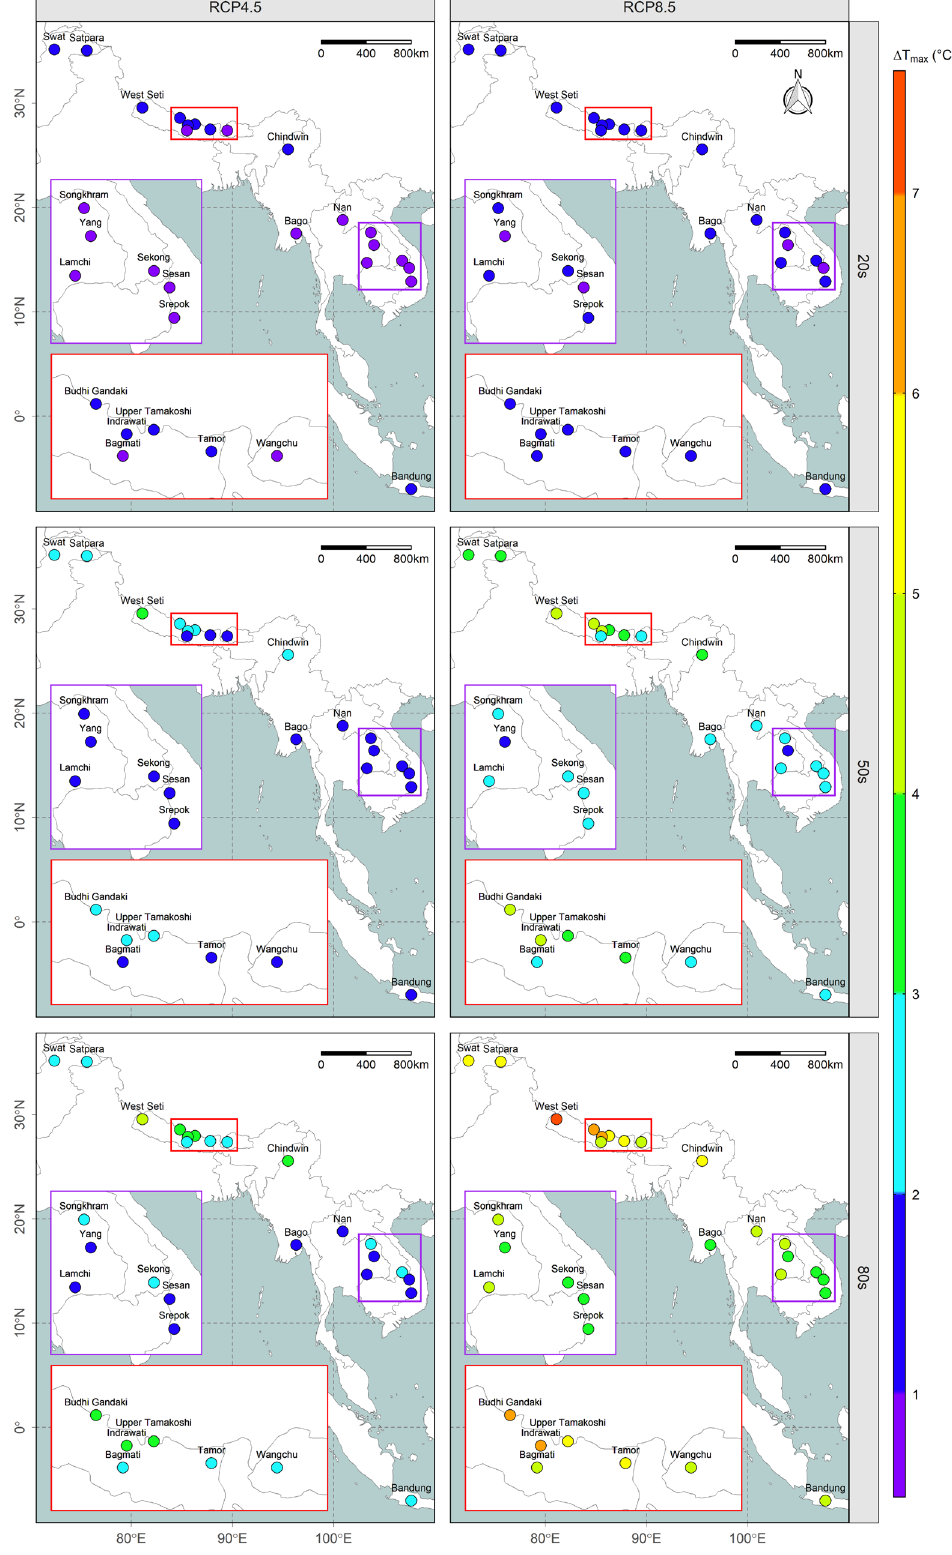
Figure 1. Spatiotemporal variation in the annual maximum temperature anomaly (absolute change). The results are from an ensemble of GCMs, with each facet corresponding to a different emission scenario (RCP4.5 or RCP8.5) during various time periods (20 s, 50 s, or 80 s) as indicated at the top and left side of the map, respectively while the two insets are enlarged and colour-coded 20–22